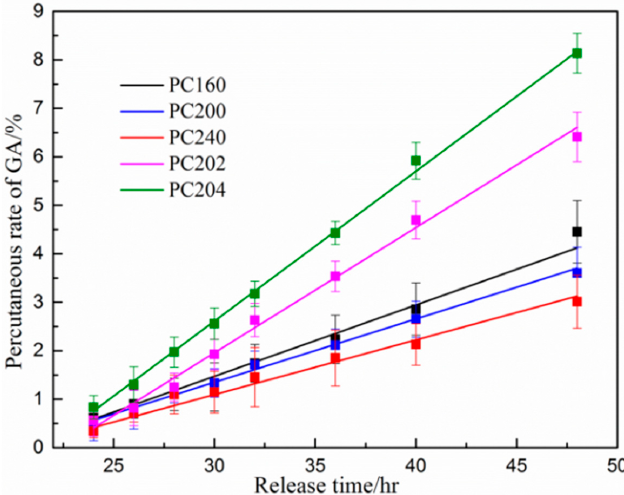
Figure 5. In vitro cumulative diffusional release of gallic acid (GA) from various P407/CMCs hydrogel matrix penetrated through porcine ear skin ( n = 3) (HPLC analysis: mobile phase consisting of acetonitrile and double distilled water/phosphoric acid (99.0/1.0, v / v ); flow rate: 1.0 mL/min) (the data